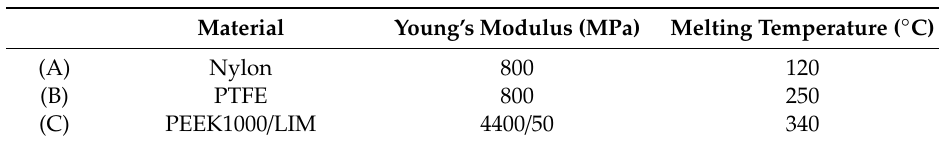
Table 3. Prototypes characteristics.